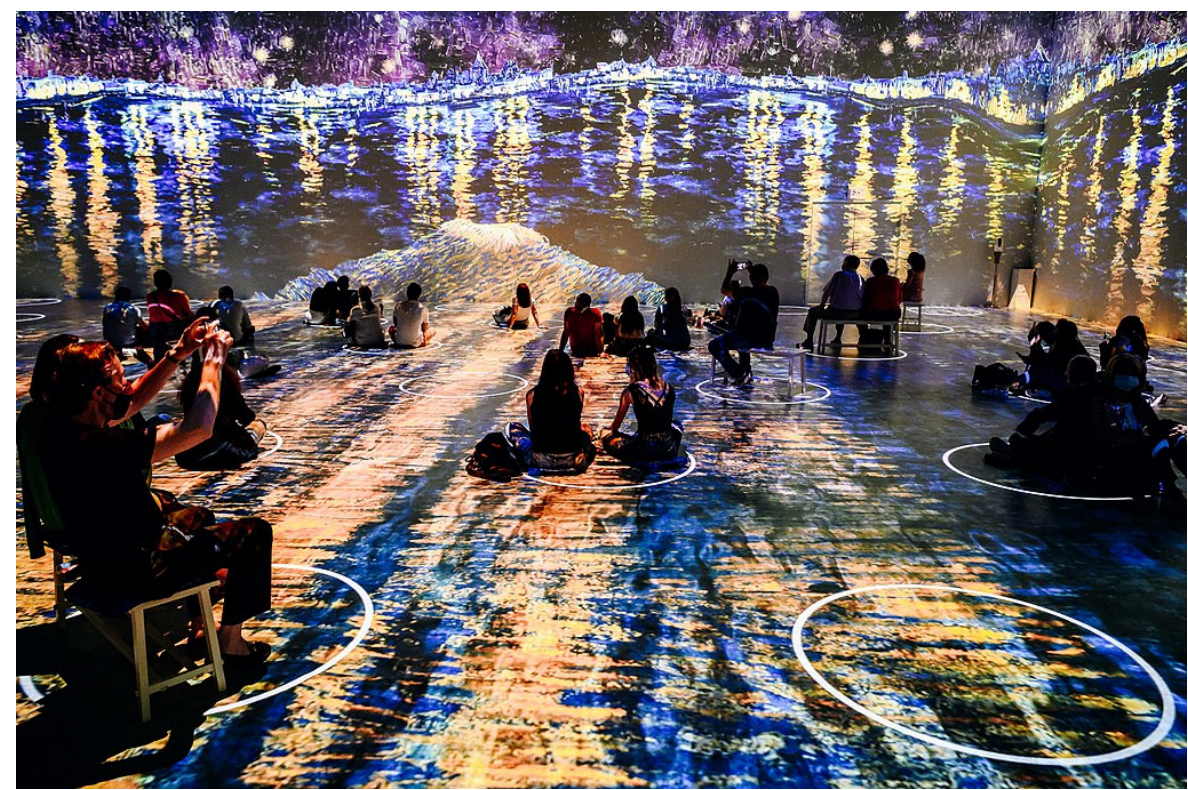
Figure 3. Installation view of Immersive Van Gogh in New York City. Photo by Nina Westervelt